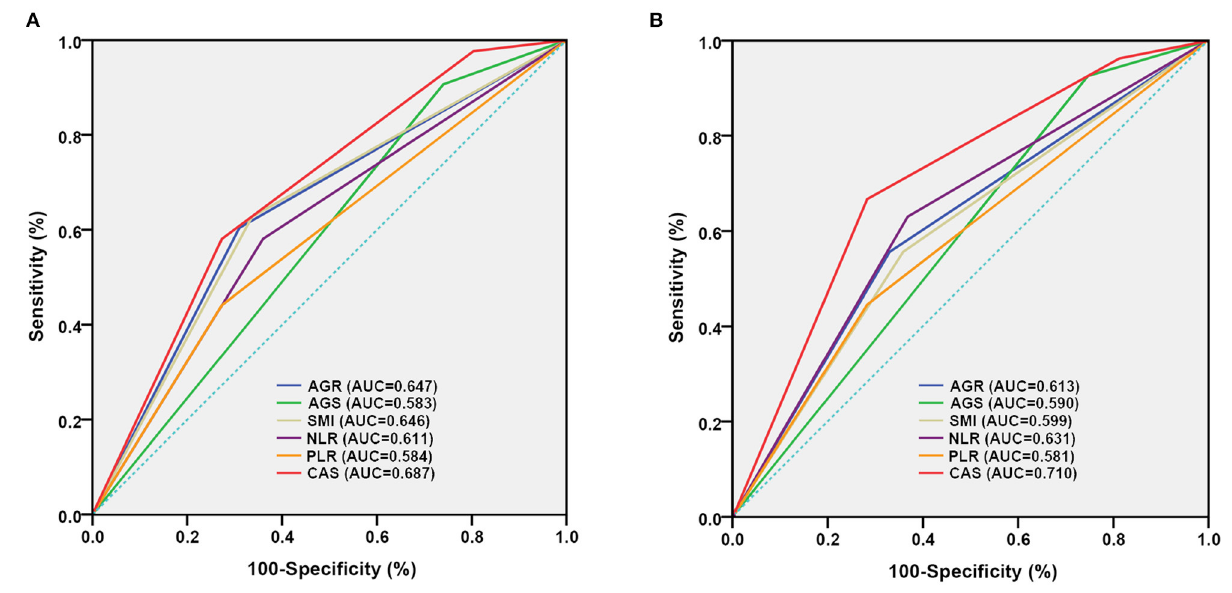
FIGURE 4 | Comparison of area under ROC curves for AGR, AGS, SMI and CAS grade in predicting OS and CSS in the training set. (A) , OS ROC curves; (B) , CSS ROC curves. OS, overall survival; CSS, cancer-specific survival; ROC, receiver operator characteristic; AUC, area under the curve; AGR, albumin to globulin ratio; AGS, albumin-globulin score; SMI, skeletal muscle index; CAS, combination of albumin-globulin score and